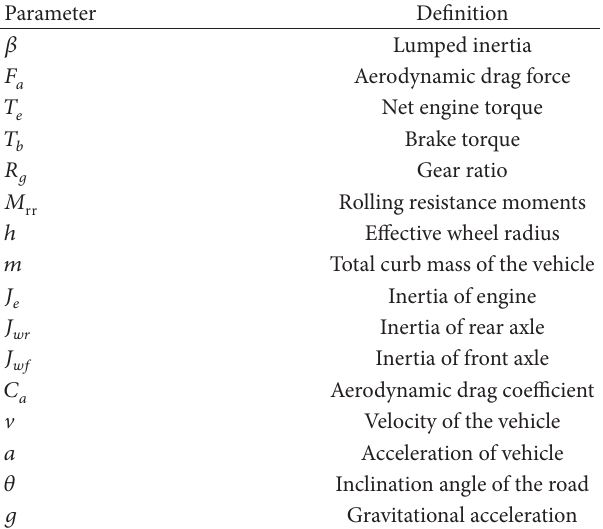
Table 1: Parameters for the longitudinal vehicle dynamics.